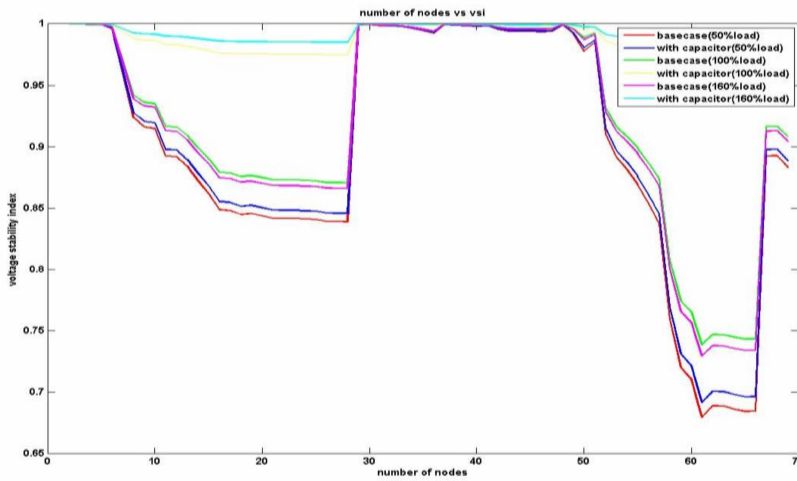
Figure 6. VSI vs. node number before and after